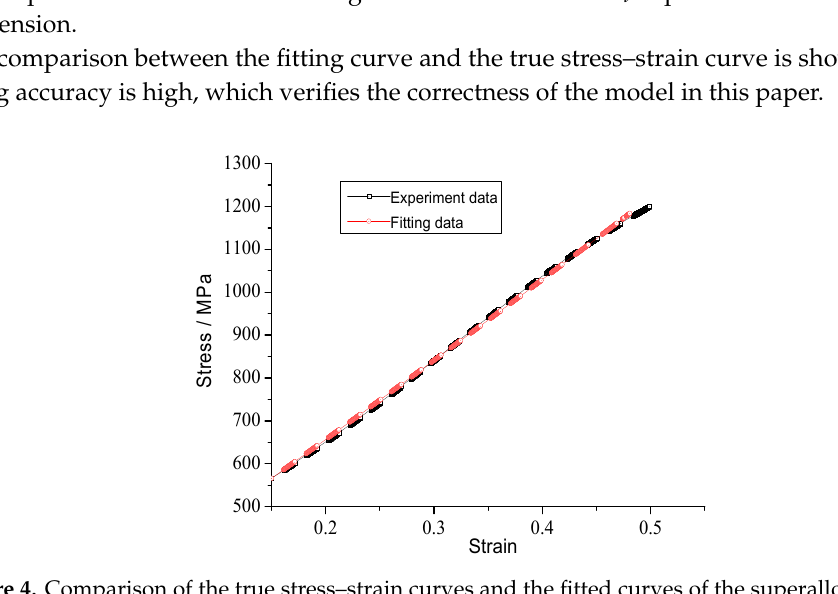
Figure 4. Comparison of the true stress–strain curves and the fitted curves of the superalloy GH1140.